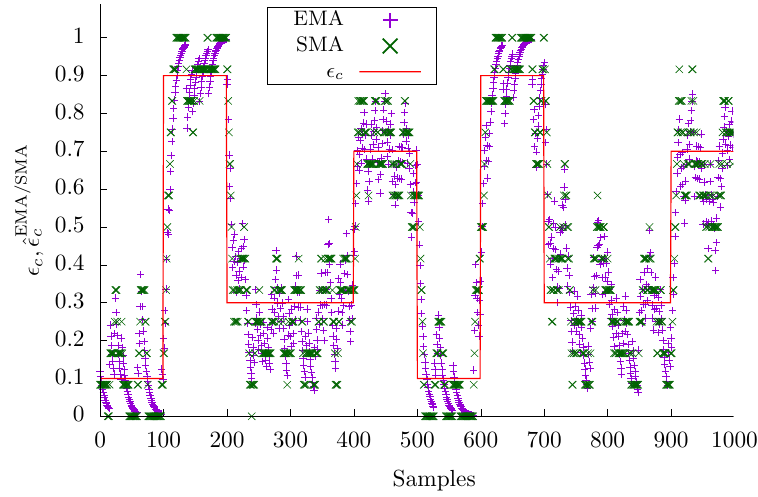
Figure 3. Real and estimated (SMA/EMA) values of (cid:101) c vs. time (sample) i